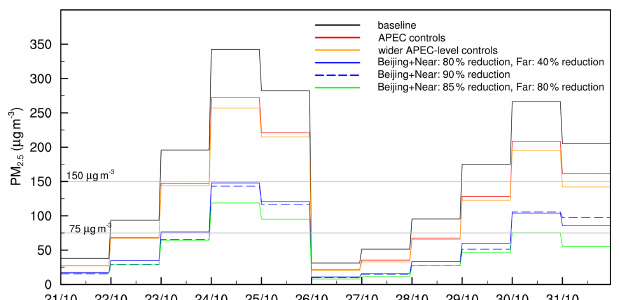
Figure 11. Average daily mean PM 2 . 5 in Beijing during Octo- ber 2014 based on emission control scenarios including controls on Beijing and near-neighbourhood sources applied during APEC (red), APEC controls extended to the far-neighbourhood region (or- ange), controls needed to attain a standard of 150µgm − 3 through- out the period (blue), and controls needed to meet a standard of 75µgm − 3 on 30 October